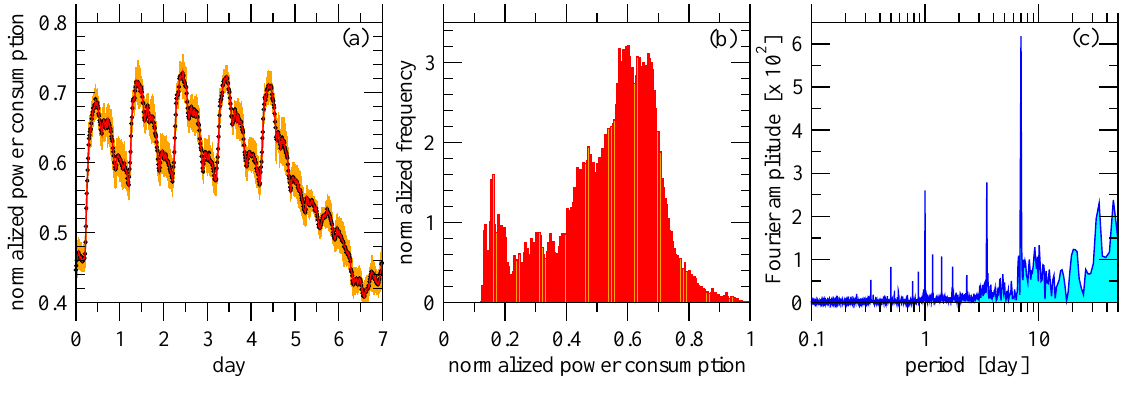
Figure 5. (a) Weekly power consumption pattern (black) extracted by averaging 9 regular working weeks in 2008 starting from day 39454 (Figure 4, middle). Red line shows the same curve with a temporal resolution of 10 min, orange is the standard deviation. (b) Histogram of the power consumption obtained from the full record. (c) Fourier analysis reveals the strong daily and weekly cycles, the other thin peaks are harmonics.